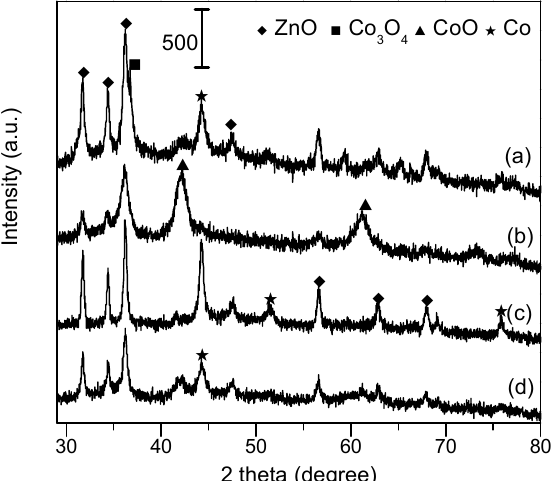
Figure 5. XRD patterns of the reduced catalysts of (a) Co 2 Zn 1 , (b) Co 2 Zn 1 Sc 0.3 , and the spent catalysts of (c) Co 2 Zn 1 ; (d) Co 2 Zn 1 Sc 0.3 .